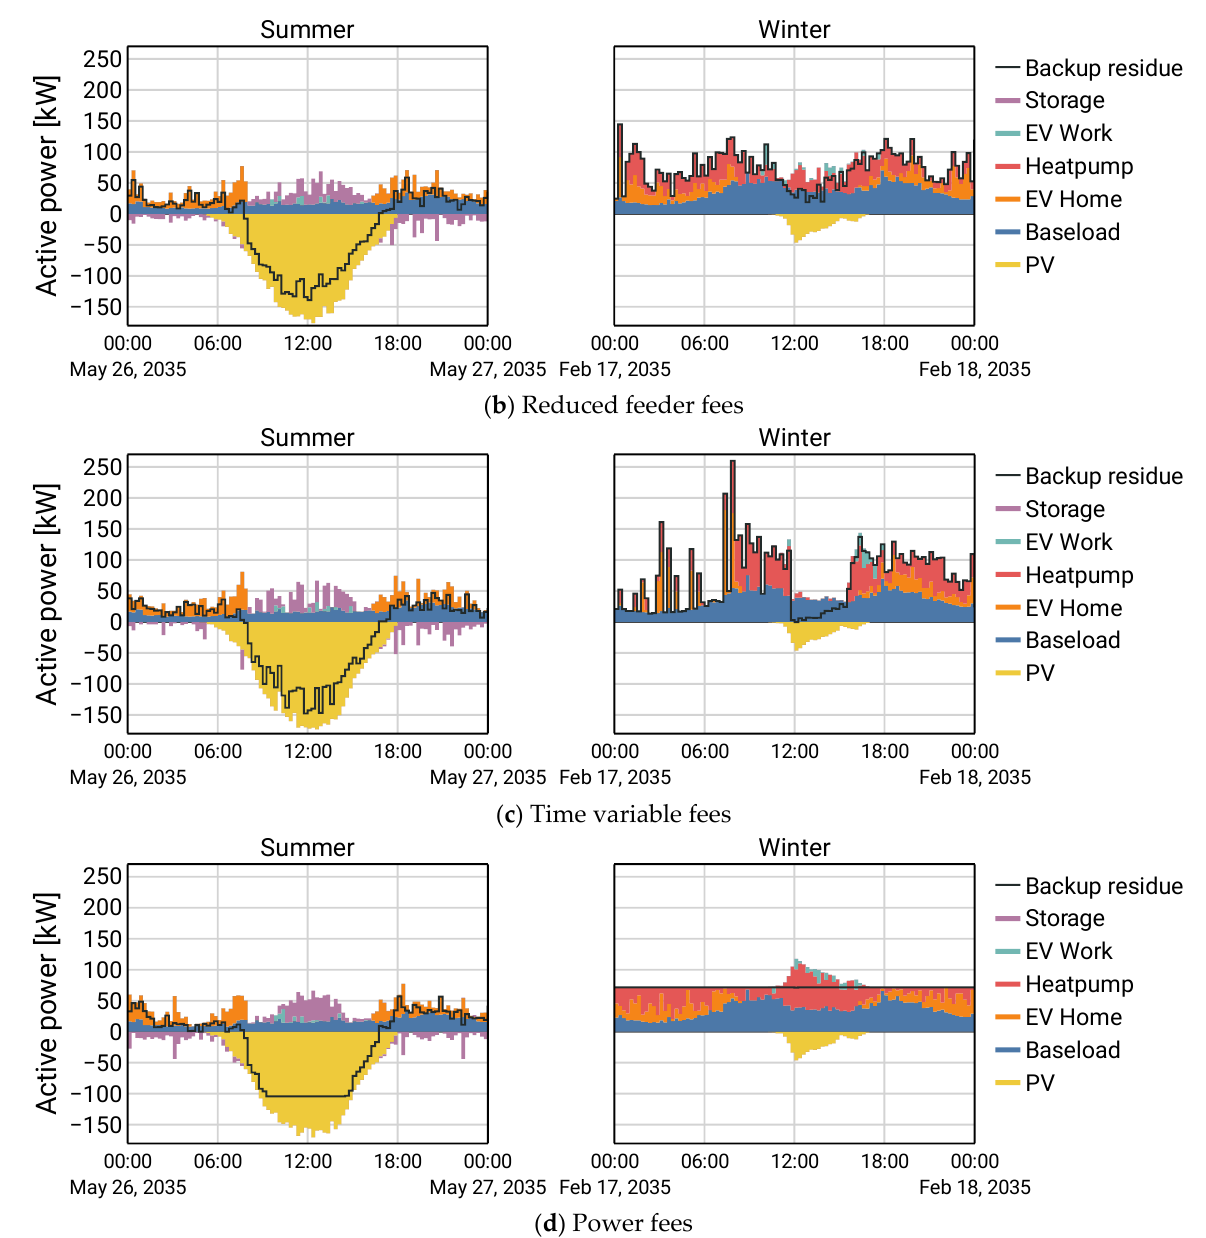
Figure 5. Market matching results on an asset level for sample summer and winter days and a variation of grid tariff scenarios, the scenario year 2035 and the rural distribution grid.